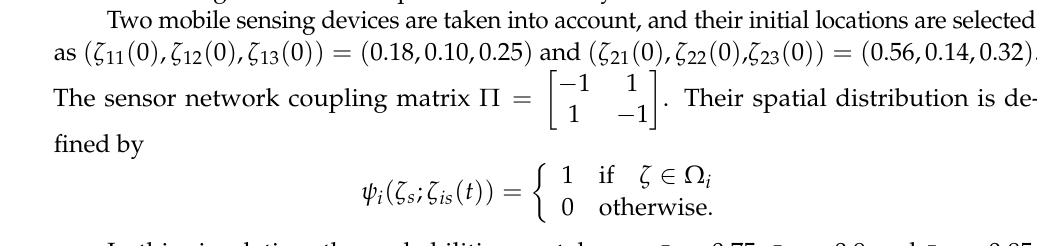
Figure 2. The evolution of the 3D nonlinear distributed parameter systems. The coordinate system in Figure 2 represents a three-dimensional space. Hence, the states of the system in three dimensions at time t = 0.25, 1, 2, 5 s, respectively, need to be shown using four different spatial coordinate